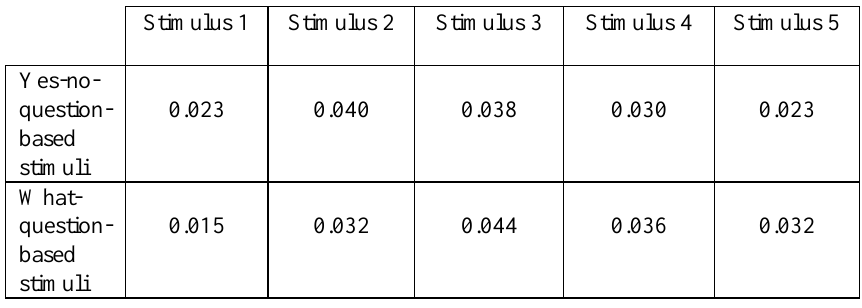
Table III. Standard error of the mean of the identification rate for yes-no-question- and what-question-based